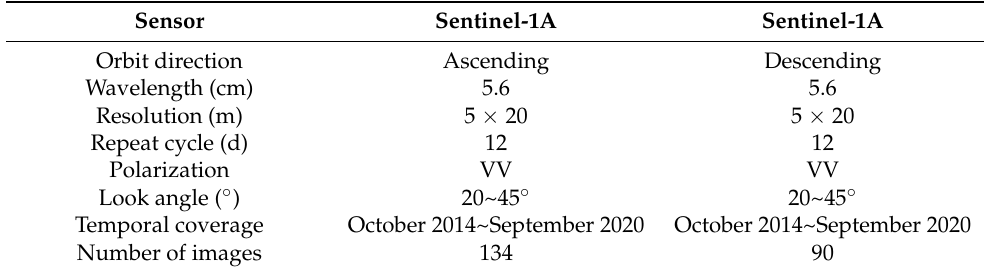
Table 1. The basic parameters of the SAR datasets.